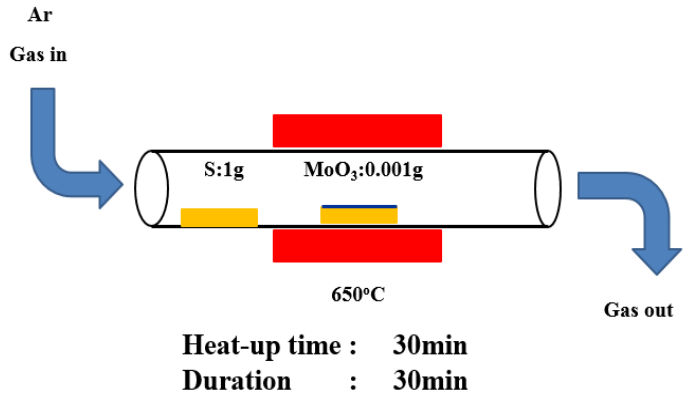
Figure 1. Schematic of a growing MoS 2 film.